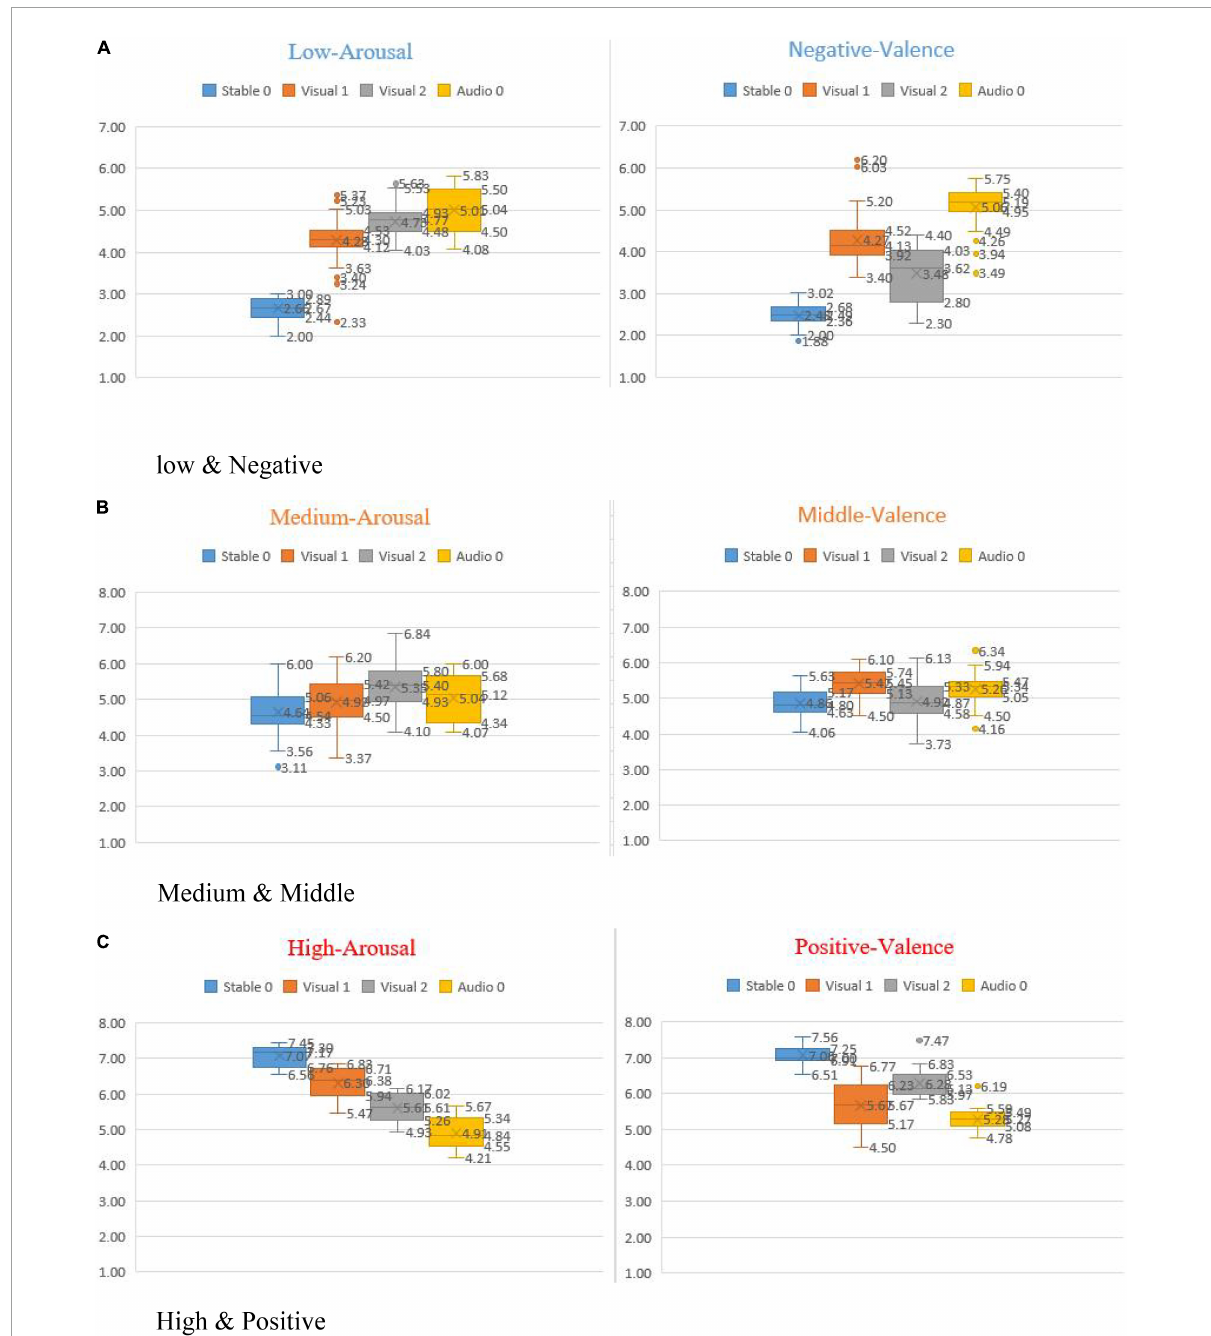
FIGURE8 Box plots of emotion scores of multimodal database. (A) Low and negative. (B) Medium and middle. (C) High and positive.